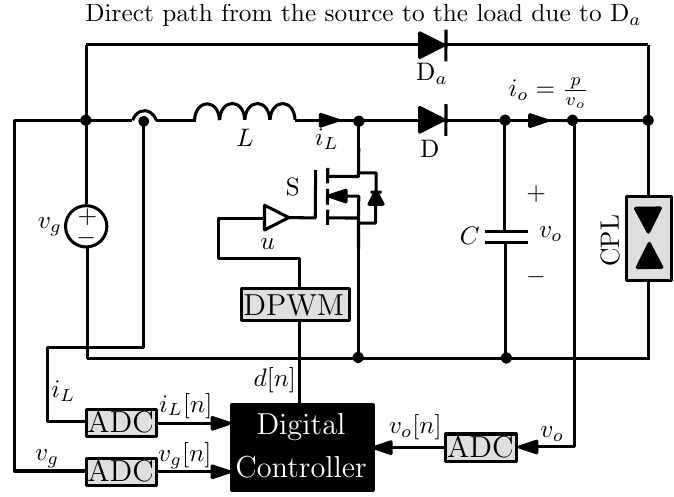
Figure 5. Schematic circuit diagram of a boost converter with